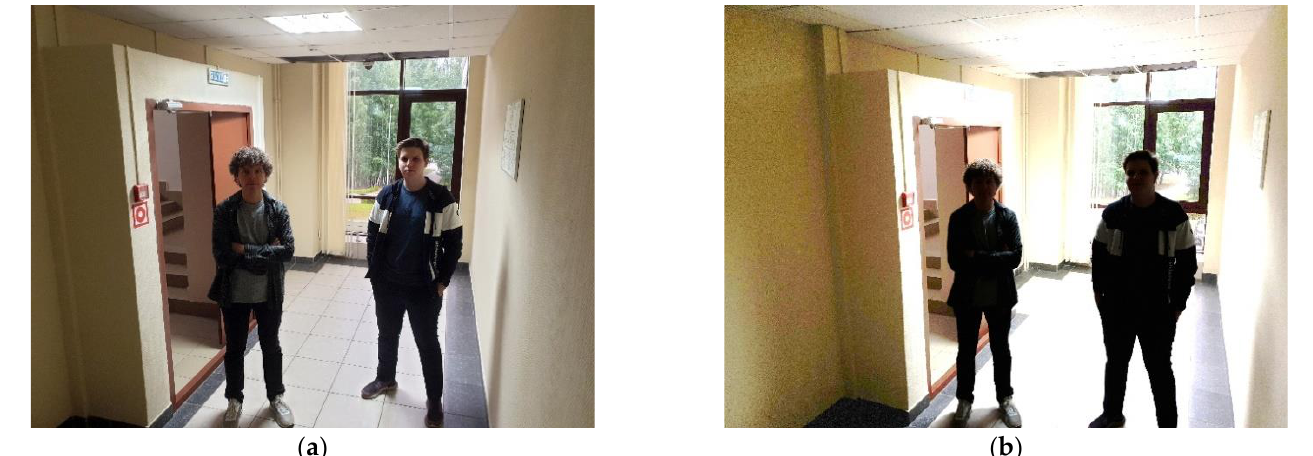
Figure 5. Highlights in the camera image: ( a ) WDR on; ( b ) WDR off.